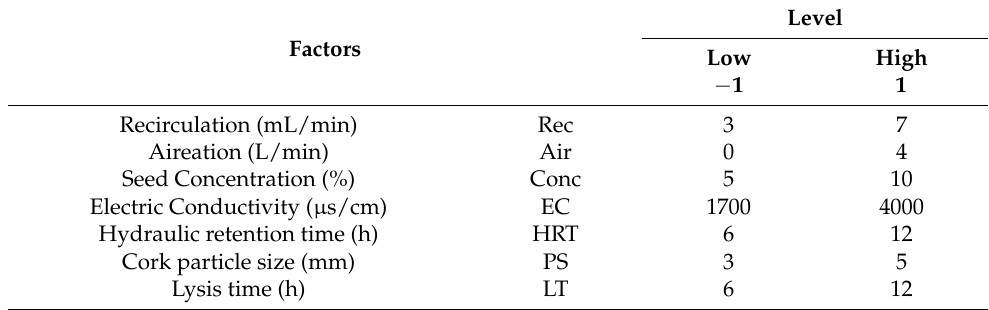
Table 1. Independent factors and their low and high values of a 2 7 − 4 fractional factorial design for the reduction of E. coli in trickling cork biofilters functionalized with Mo Se.